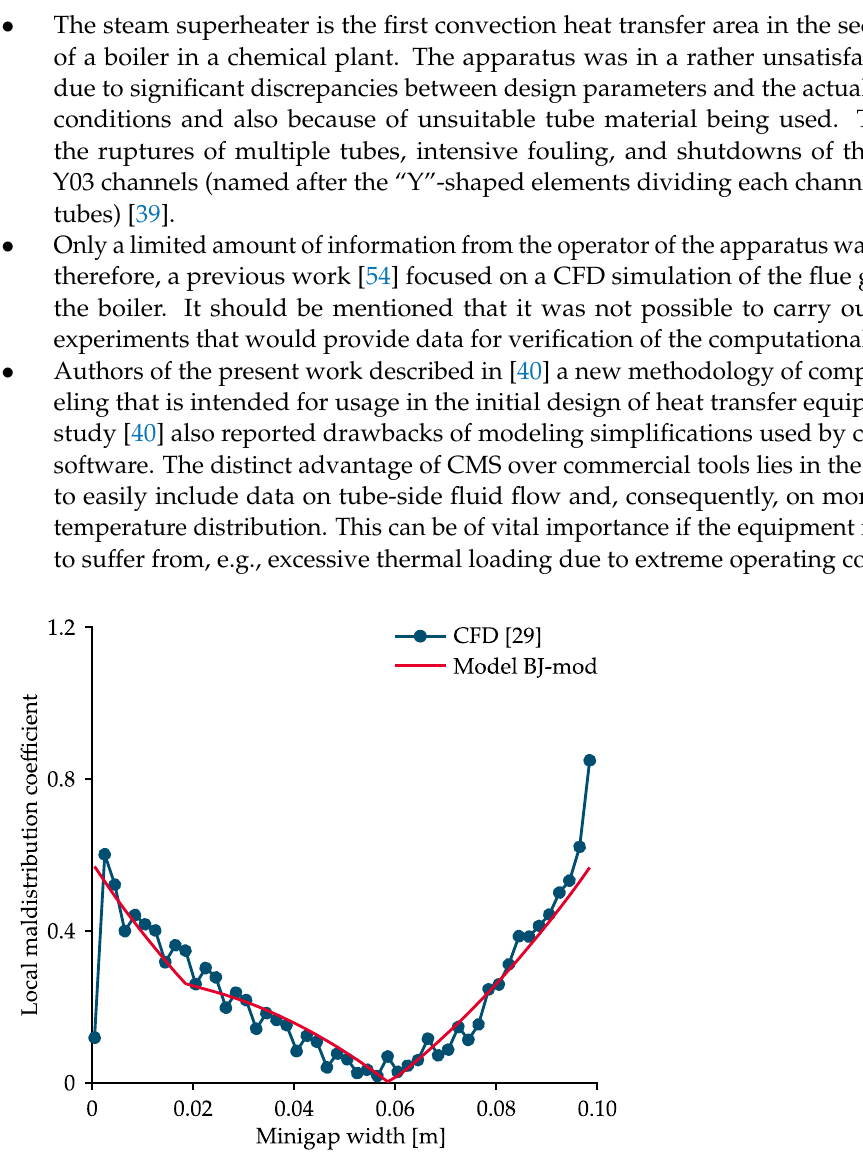
Figure 18. Comparison of the analytical (Model BJ-Mod) and numerical data (taken from the literature) for the second system configuration (header depth of 2 mm), momentum coefficients for flow in the distributor—0.65, collector—3.10.